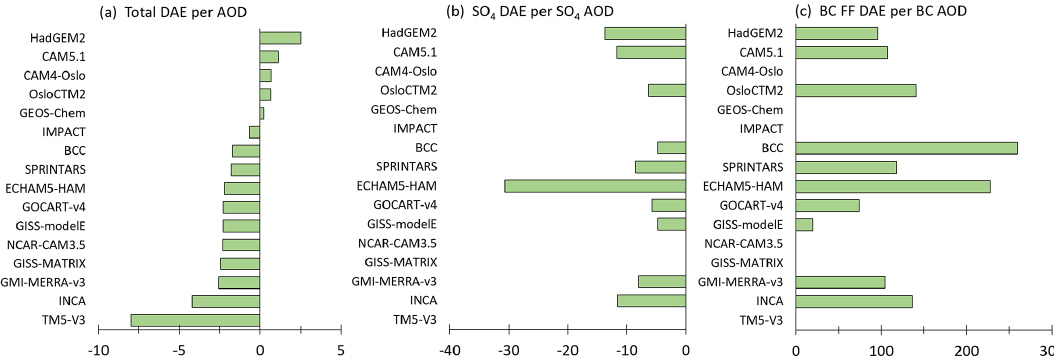
Figure 16. Arctic annual mean DAE per AOD for all AeroCom Phase II models, total (a) , sulfate (b) , and BC FF (c) . Values for sulfate and BC are missing for GEOS-Chem, IMPACT, NCAR-CAM3.5, GISS-MATRIX, CAM4-Oslo and TM5 (see Table